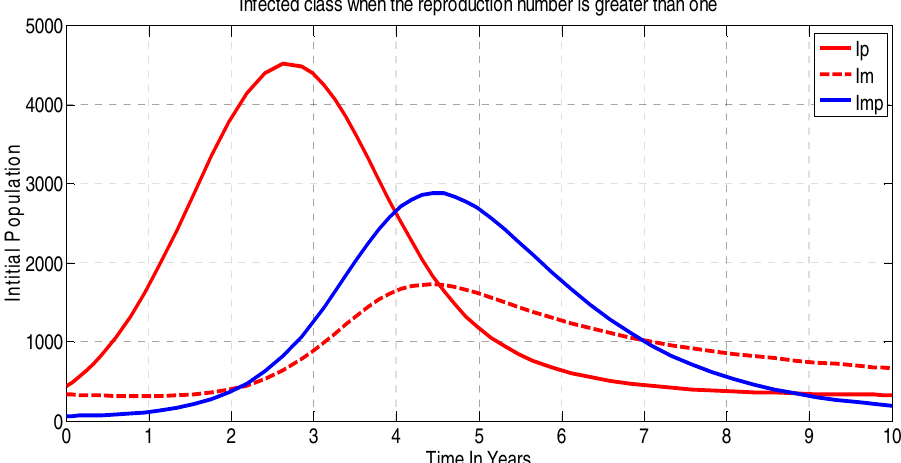
Figure 4. Infectious class when reproduction number is greater than one.